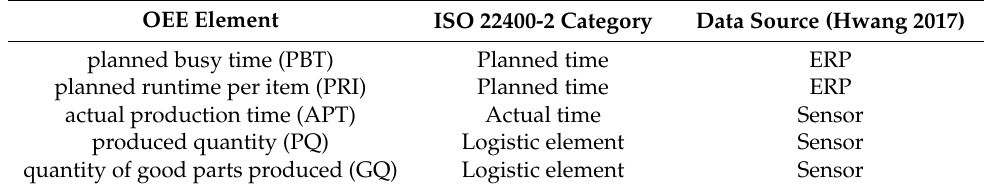
Table 6. Elements of OEE calculation (ISO 22400-2, Hwang